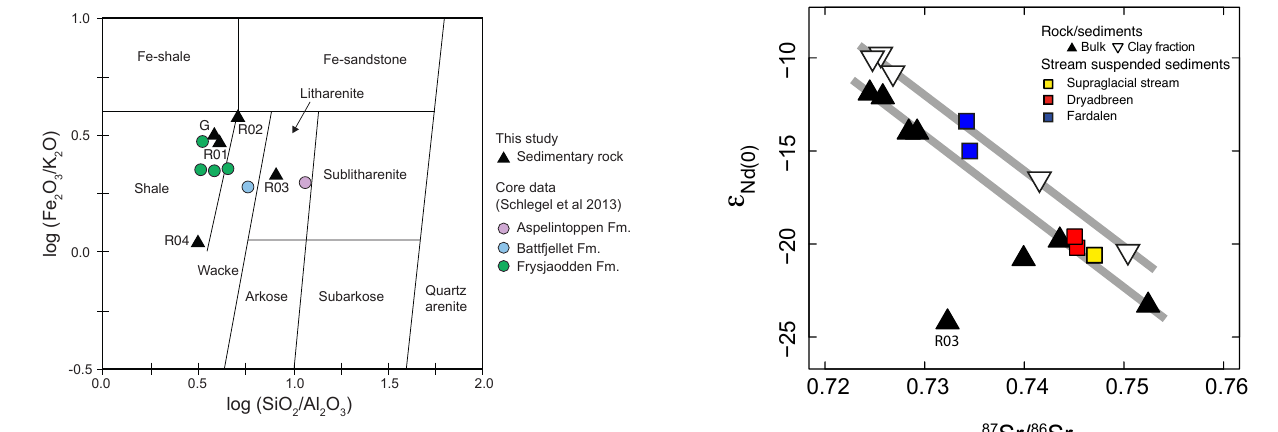
Figure 5. A plot of 87 Sr / 86 Sr vs. ε Nd. The grey lines highlight the parallel trends of the bulk and the clay-sized fraction data. Sam- ple R03 is a litharenite whereas the other samples are predominantly shale (Table